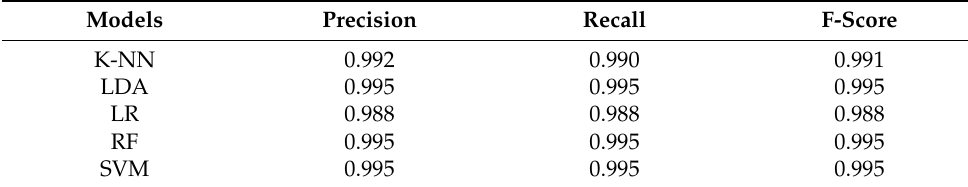
Table 4. Precision, Recall, and F-Score